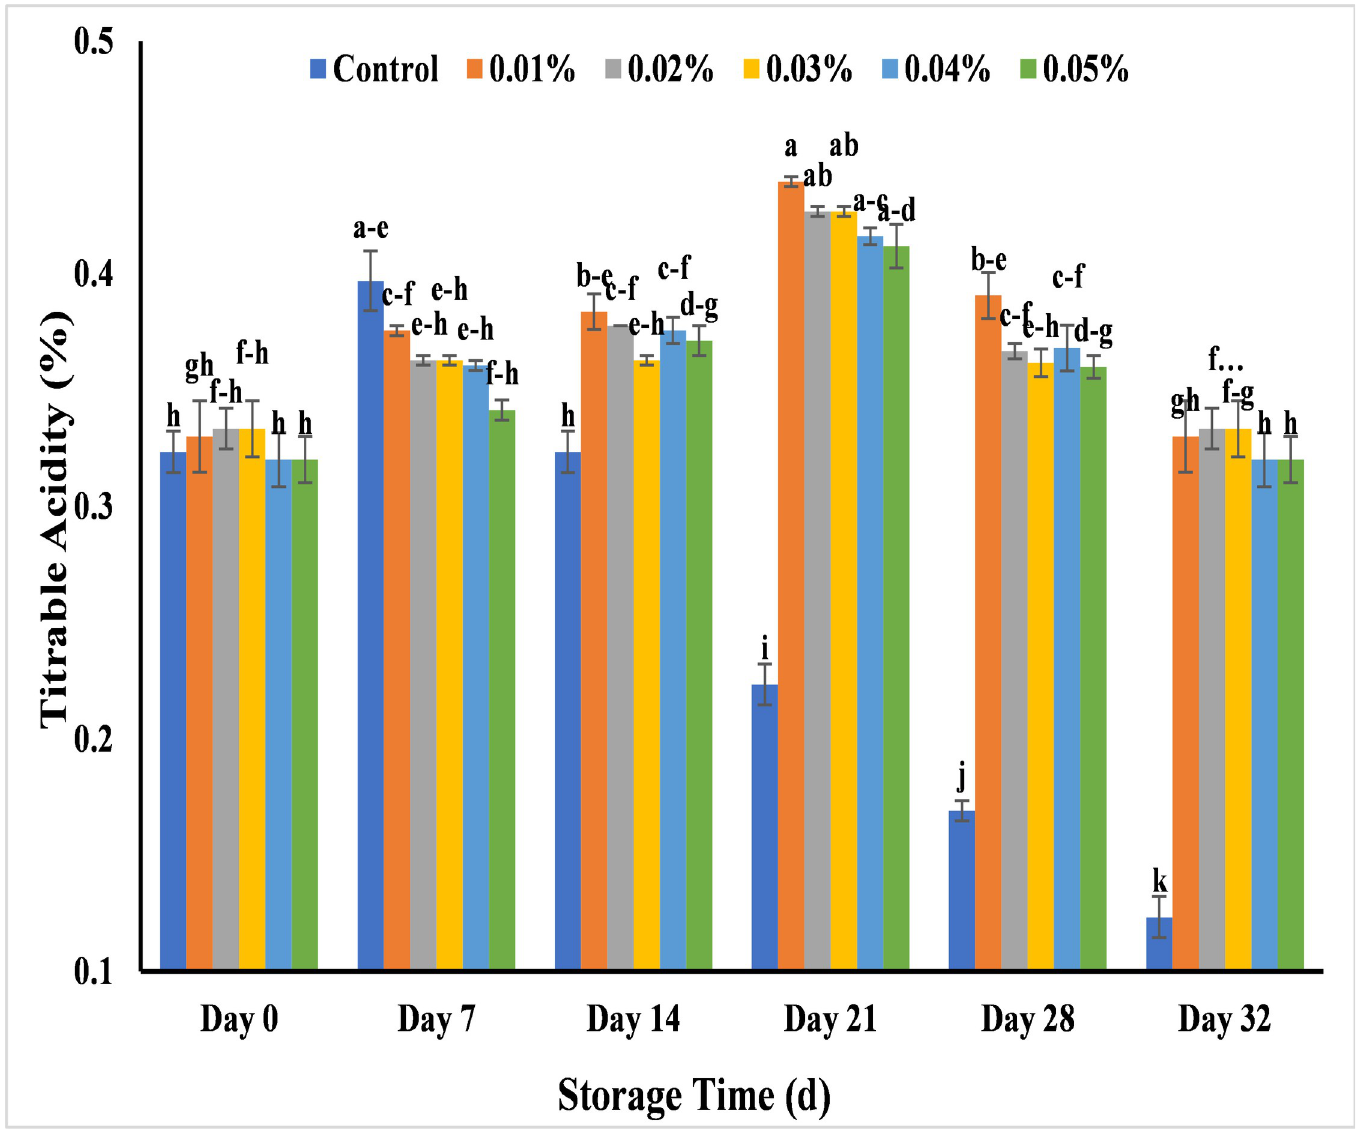
Fig 17. Effect of AgNPs concentrations (T0 = control, T1 = 0.01%, T2 = 0.02%, T3 = 0.03%, T4 = 0.04%, T5 = 0.05%) on titrable acidity (%) of Cavendish banana (BASRAI) during 32 days of storage.